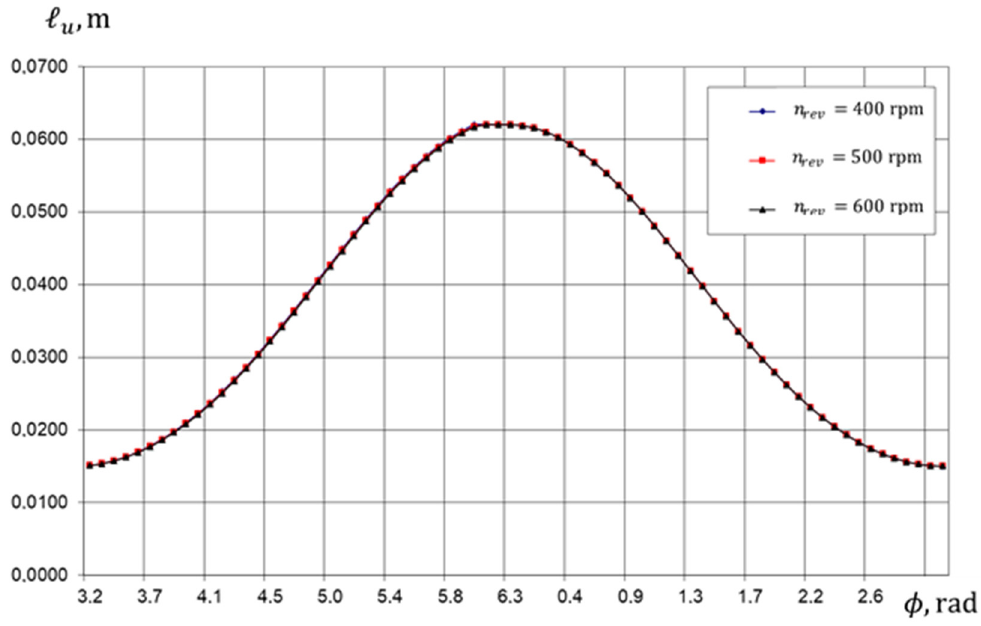
Figure 21. Dependence of the length of the gap seal on the angle of rotation of the crankshaft.